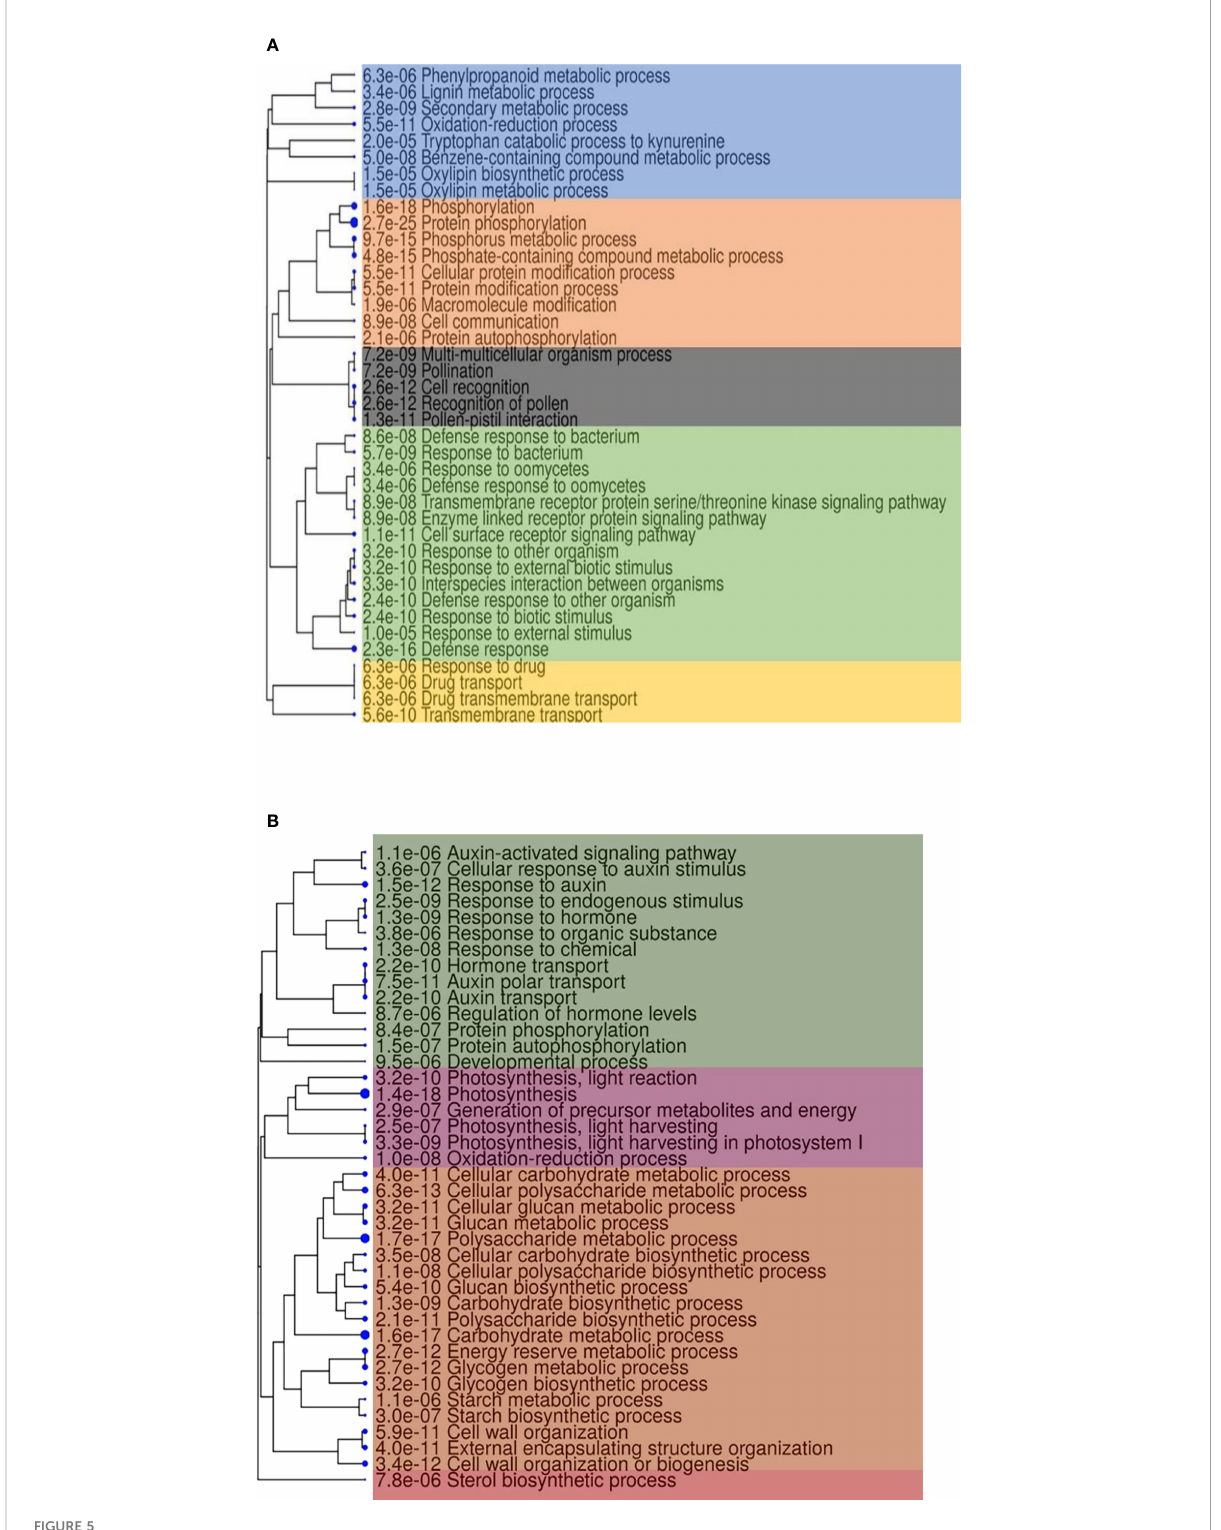
FIGURE 5 A hierarchical clustering tree summarizing the correlation among the top 40 Gene Ontology biological process enrichment of core genes. (A) Upregulated and (B) downregulated. Biological processes with numerous shared genes are clustered together. Blue dots with numbers indicate the false discovery rate values. High signi fi cance is designated with bigger